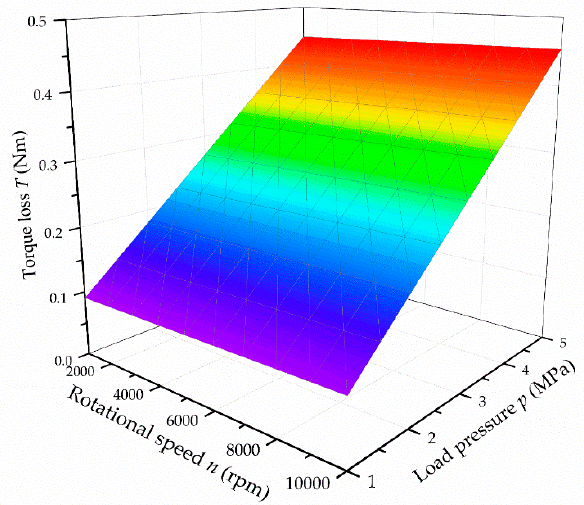
Figure 16. Theoretical torque characteristics.